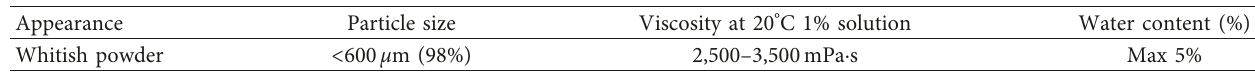
Table 6: Properties of methylcellulose.